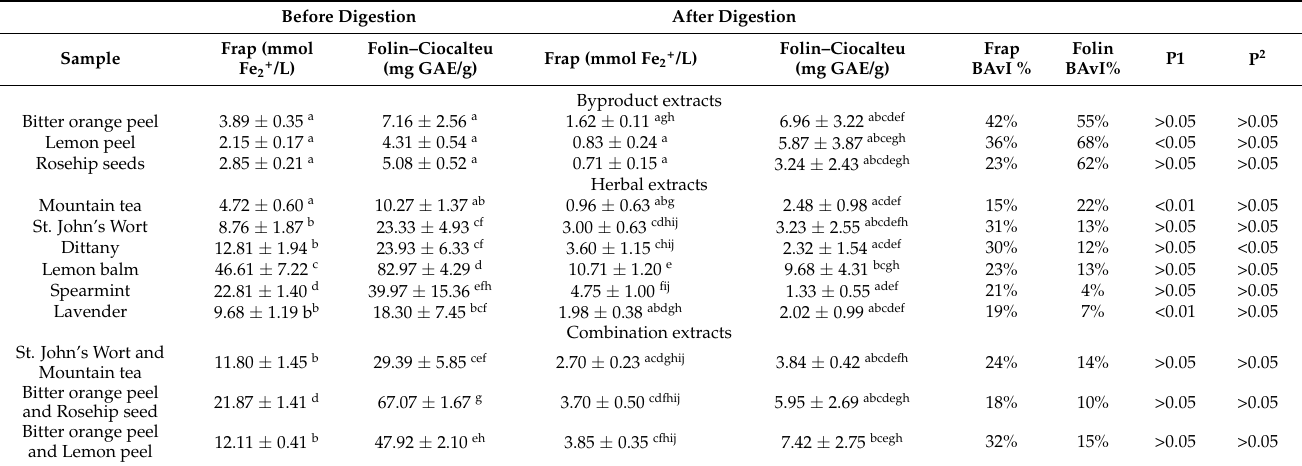
Table 1. Spectrophotometric determination of total antioxidant and phenolic content of selected plant byproduct and herbal extracts and their bioavailability indices.